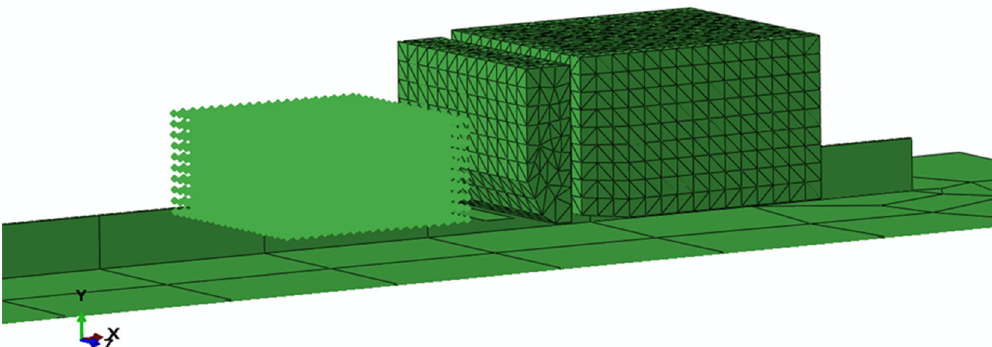
Figure 4. The assembled